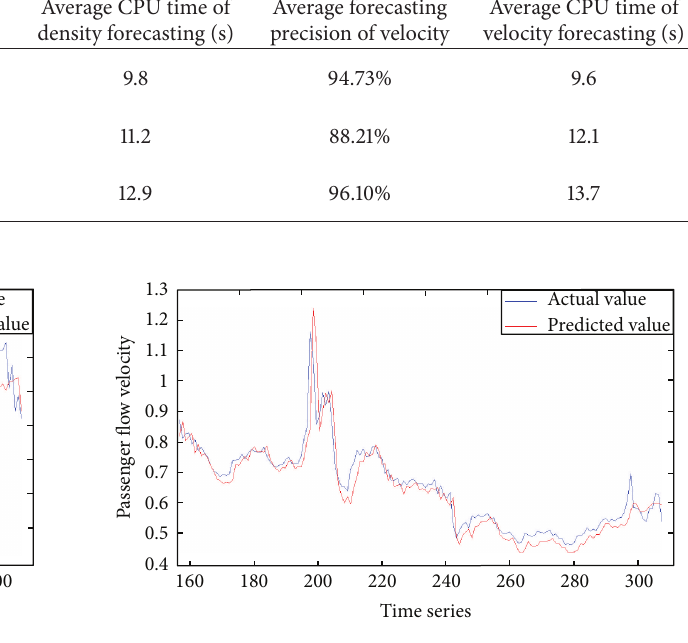
Figure 8: Comparion between actual value and forecasting value of passenger flow velocity based on hybrid temporal-spatio forecasting